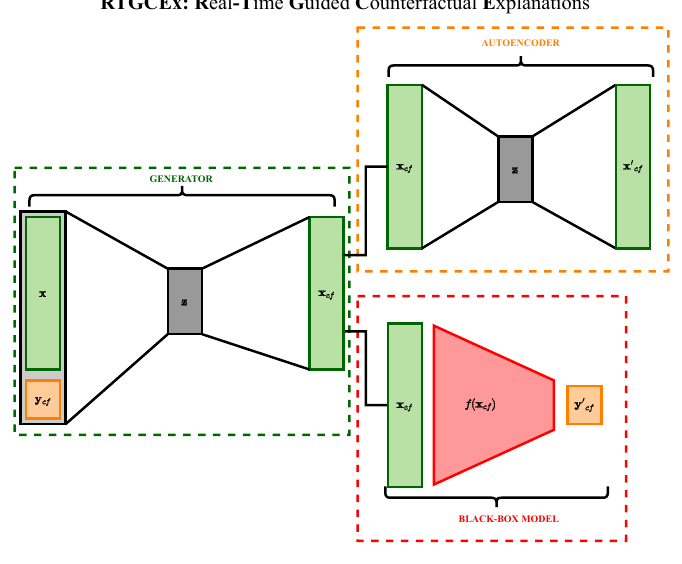
Figure 1. Real-Time Guided Counterfactual